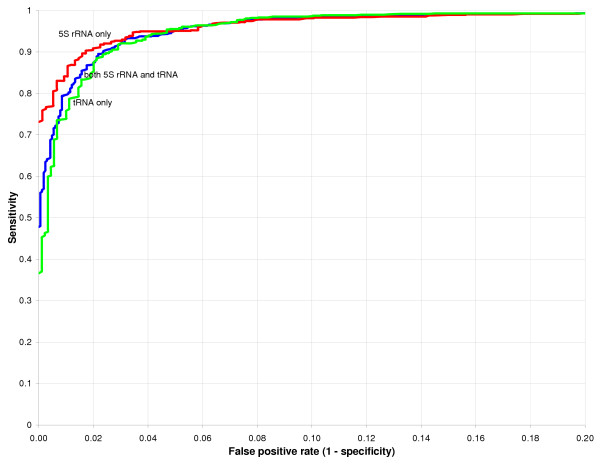
Quality of classification using the z score method, broken down by ncRNA family. ROC curves showing effectiveness of the best control generation method for sequence pairs (i.e. columnwise shuffle of global alignment at parameter M = 8) for 5S rRNA by itself (red), tRNA by itself (green), and both combined into one test set (blue). The 5S rRNA or tRNA sequences in the test set are the same as those used for the test set in Figures 3, 4 and 5.